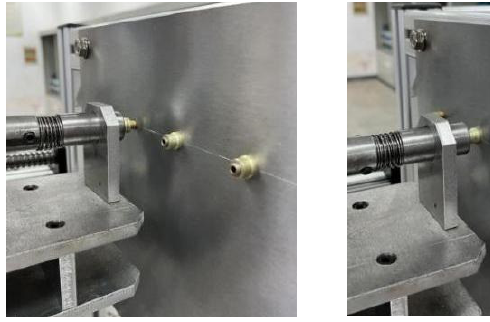
Figure 18. Fastening of hi-lok nut.